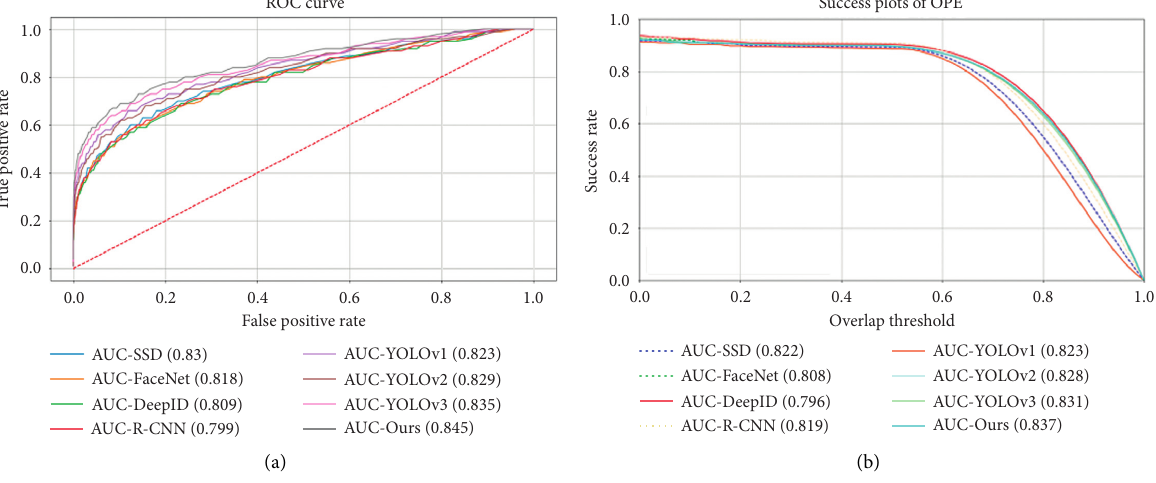
Figure 5: ROC and success rate curve of VOC2012 dataset.